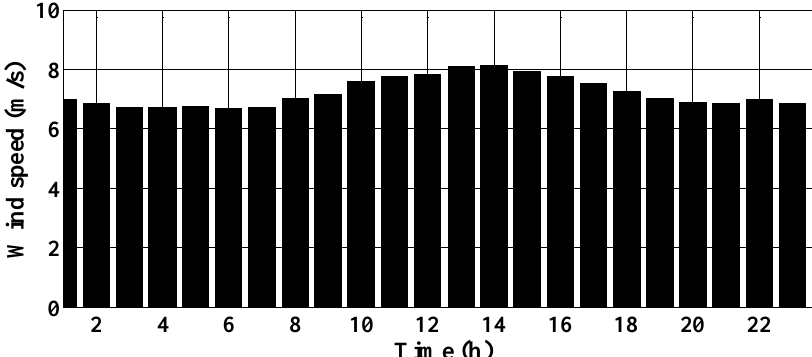
Figure 14. The gniTsacerof wind speed. Figure 14. The forecasting wind speed.